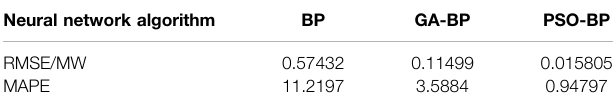
TABLE 2 | Prediction error data of each neural network algorithm. Neural network